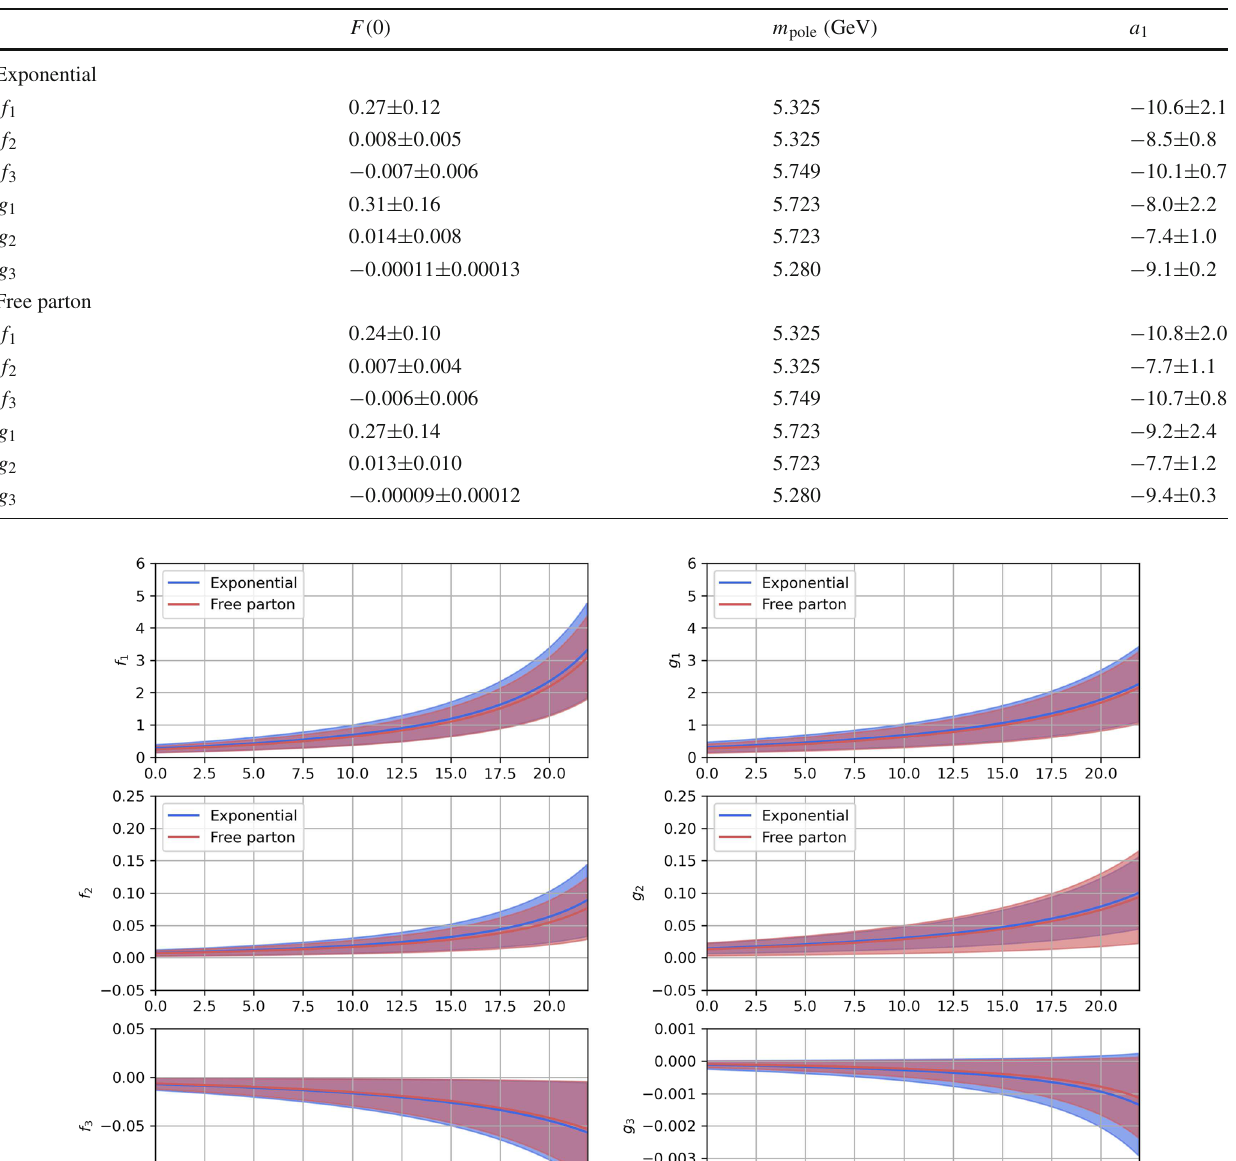
Table 12 Values of the parameters for the form factors in Eq. (44)